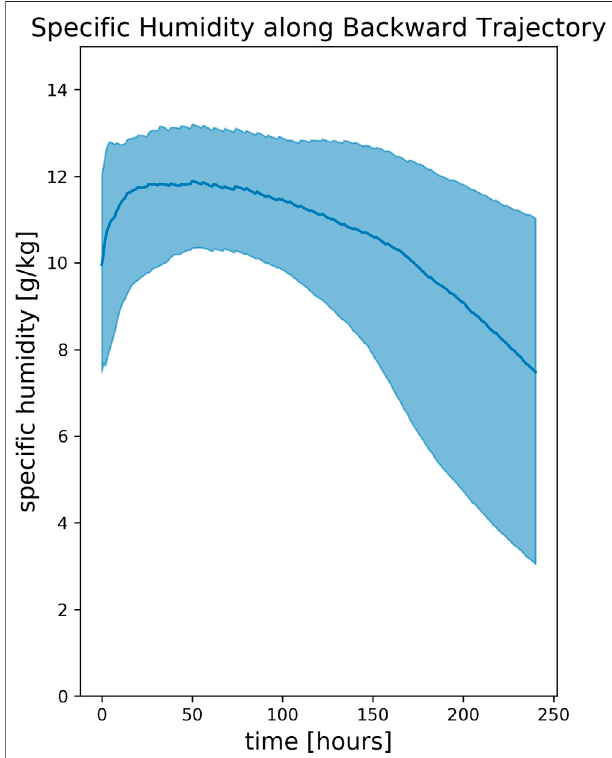
FIGURE 4 | Median temporal evolution of speci fi c humidity along the precipitating backward trajectories. The fi lling describes the quartiles of all